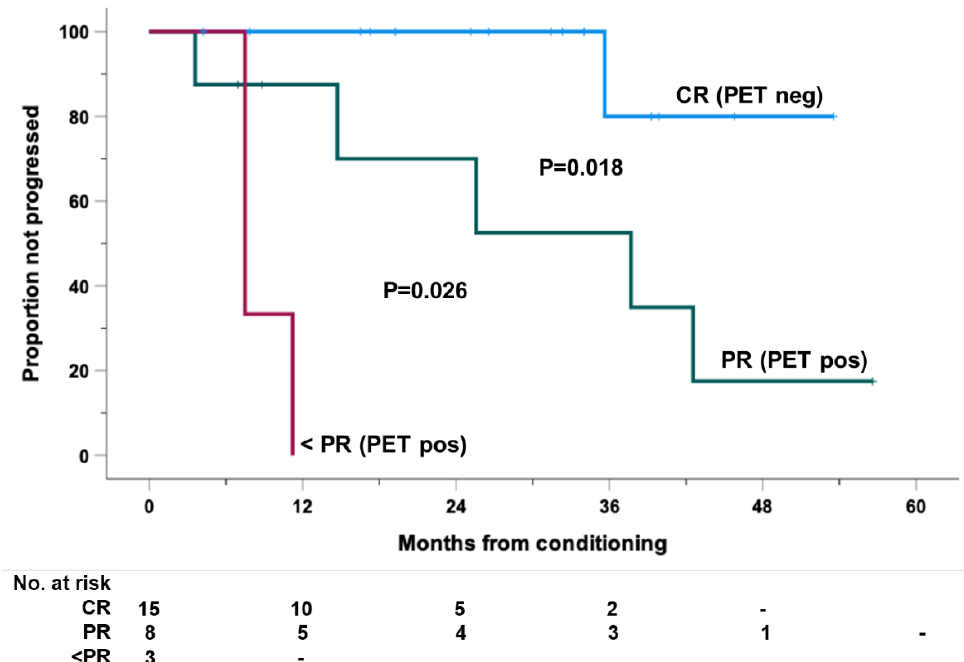
Figure 3. Progression-free survival (PFS), calculated from the day of conditioning, for the entire cohort of 26 high-risk patients with RR-HL who received consolidation with PD1-blockade after autologous stem cell transplantation (ASCT). Cases were clustered according to the achievement of CR (PET neg; DS ≤ 3), PR and less than PR (PET pos; DS ≥ 4) at the first imaging evaluation after ASCT and before start of PD1-blockade.